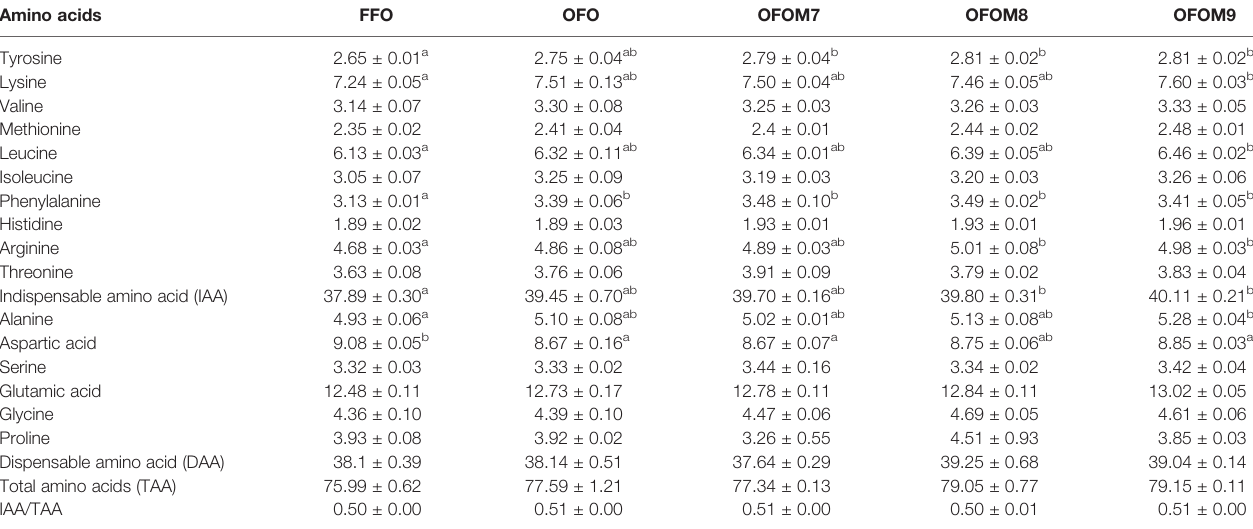
The results are presented as the means ± SEM (n = 3). Values with different superscripts in the same row are signi fi cantly different (p < 0.05).